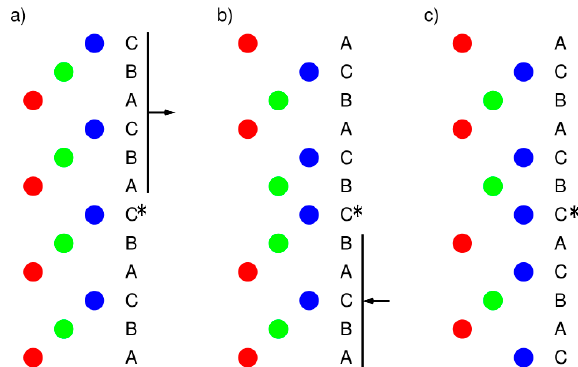
Figure 1. Schematic explanation of the model used in the computations: ( a ) Initial configuration separated from the rest by a “vacuum slab” 0.6 nm thick; ( b ) configuration imposed by the first displacement operation—layers numbered 1–6 in the upper part; ( c ) configuration imposed by the second displacement operation—layers numbered 1–5 in the lower part. The asterisks indicate the position of the atom that was replaced by the alloying element. The supercell for calculations was created by duplication twice along of the surface plane lattice vectors to generate a 2 × 2 supercell. One atom of Al was replaced by an alloying element for generalized stacking fault energy calculations.